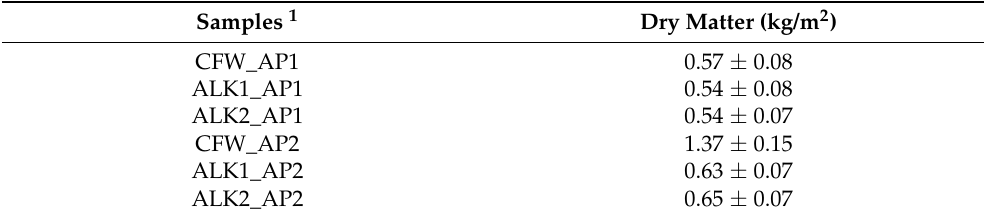
Table 1. Quantity of dry matter retained after one month for all products and application